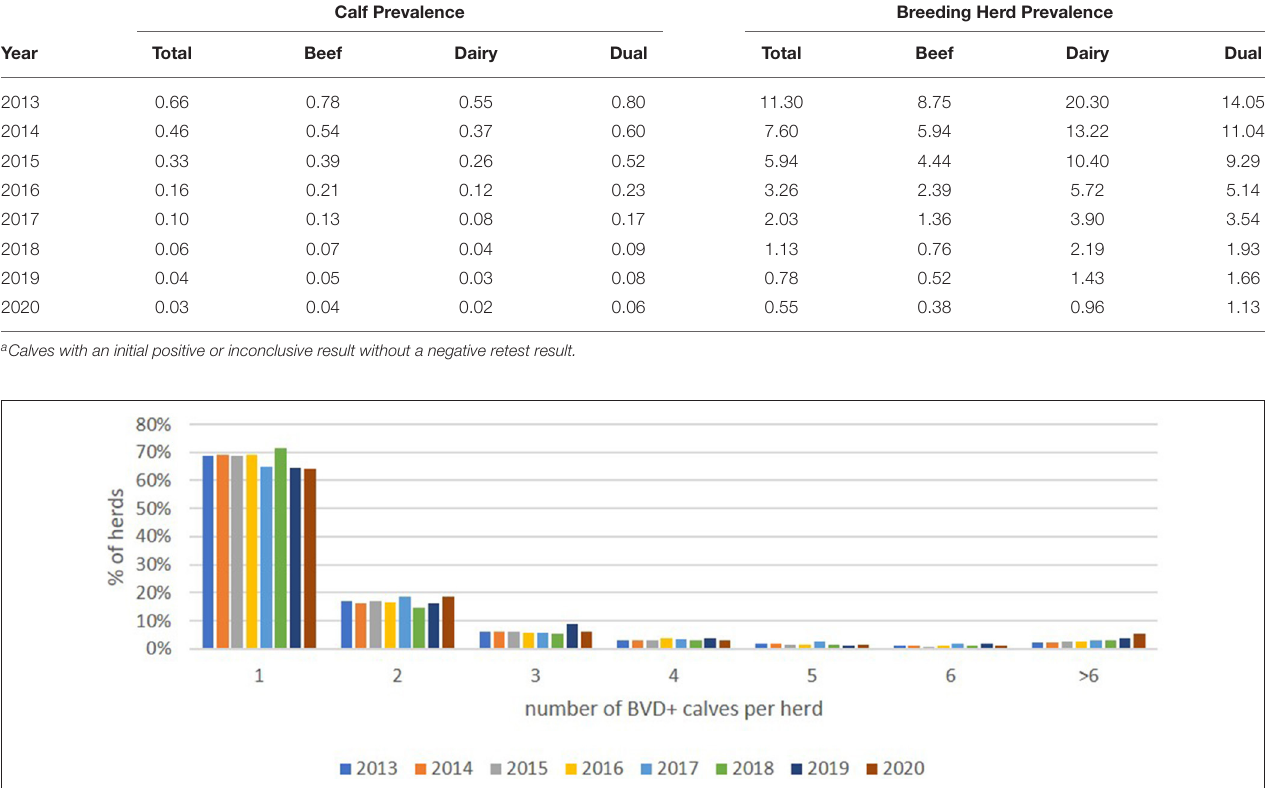
TABLE 3 | Animal-level prevalence (%) of BVD + a calves detected each year overall, and by herd type and the prevalence (%) of herds with one or more calves with positive or inconclusive results each year (overall and by herd type). Calf Prevalence Breeding Herd Prevalence Beef Dairy Beef Dairy